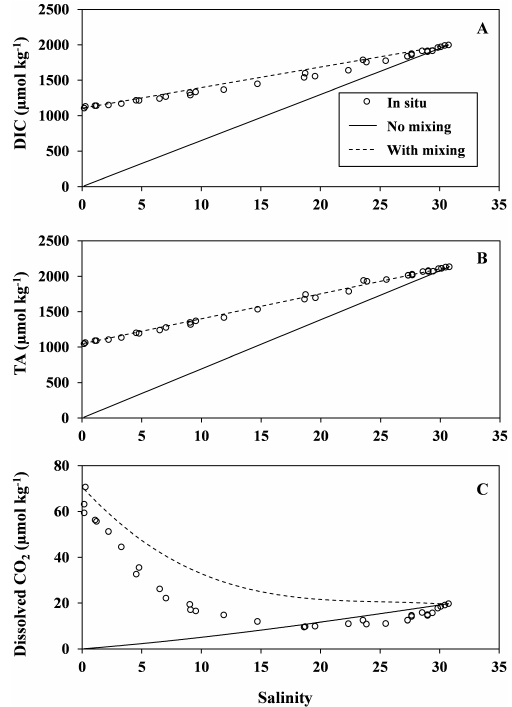
Figure 3. Concentrations of (a) DIC, (b) TA, and (c) dissolved CO 2 in the Delaware Estuary during March 2014. Open circles represent in situ concentrations. Solid lines represent values after the ocean end-member is diluted by freshwater with a concentration of zero units. Dotted lines represent concentration after mixing of river and ocean end-members. CO2SYS was used to calculate p CO 2 from measured DIC and